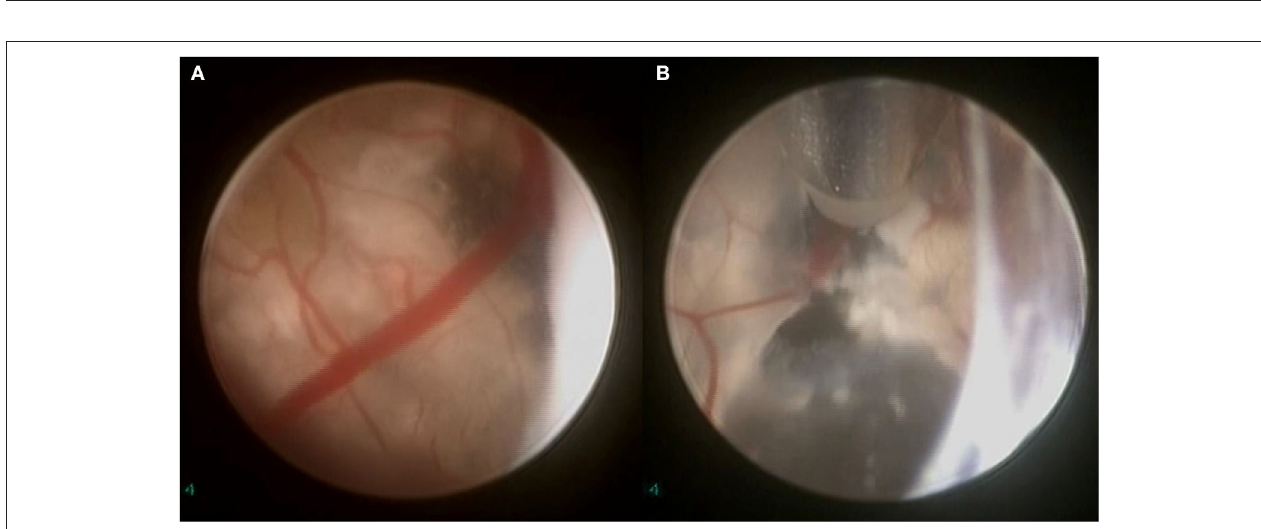
FIGURE 4 | Intraoperative photographs of a patient with an intraventricular craniopharyngioma, undergoing a frontal transcortical-transventricular approach, for tumor excision. (A) Tumor being dissected from the walls of the third ventricle (calcifications visualized in the wall of the tumor). (B) Tumor being separated from the floor of the third ventricle. (C) Solid tumor being removed, after dissection.